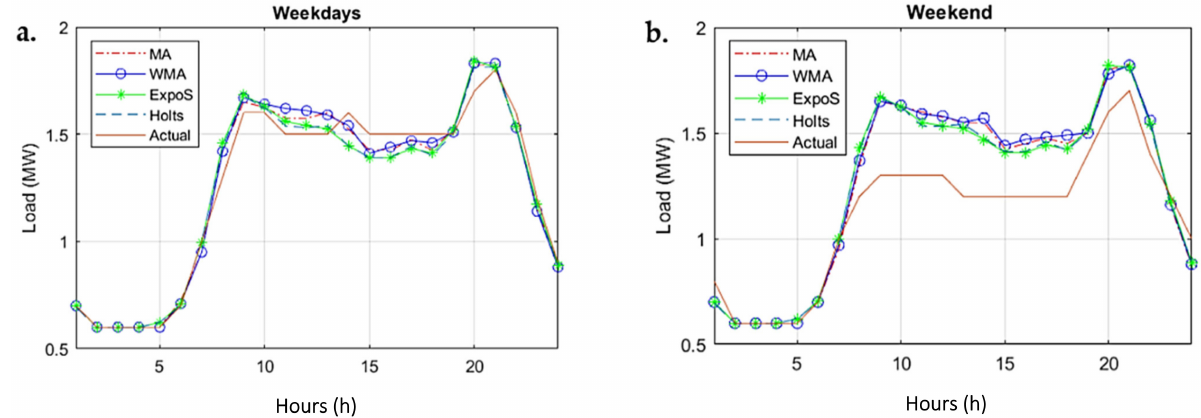
Figure 10. Actual vs. predicted forecasts achieved by conventional time series models. ( a ) Weekday forecasting. ( b ) Week- end forecasting.